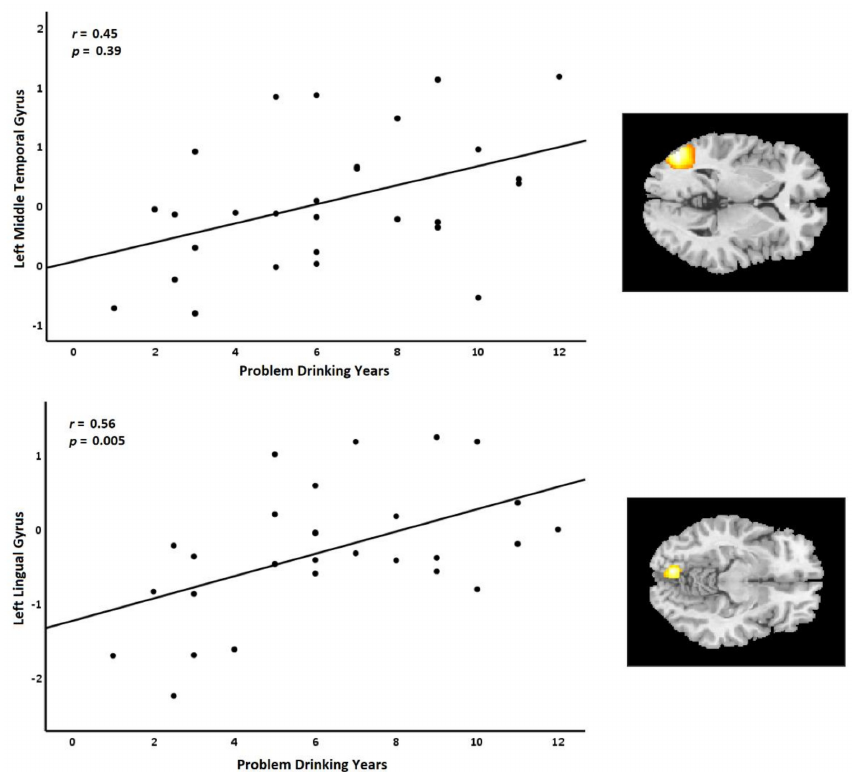
Figure 4. Positive correlations between the duration of problem drinking (years) and activation clusters were revealed by the whole-brain analysis in the left middle temporal gyrus and left lingual gyrus, elicited by the contrast of alcohol versus non-alcohol cues. Lines indicate linear associations; r = Pearson correlation; Alc = alcohol cue; Non-Alc = non-alcohol